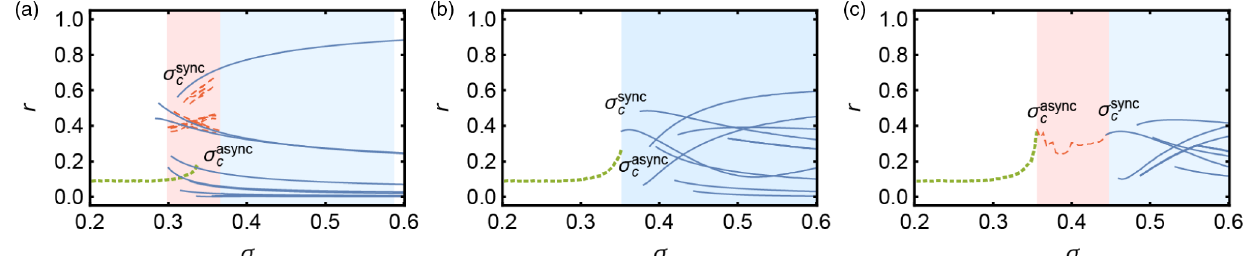
FIG. 9. Impact of oscillator heterogeneity for one profile. Order parameter r vs coupling strength σ for (a) small heterogeneity ( δ ¼ 0 . 005 ), (b) moderate heterogeneity ( δ ¼ 0 . 020 ), and (c) large heterogeneity ( δ ¼ 0 . 040 ). The lines indicate the asynchronous branch (green, dotted), fully phase-locked branches (blue, continuous), and partially phase-locked branches (red, dashed). As the heterogeneity increases, the phase-locked solutions move to the right, and the partially locked solutions disappear. The blue shade marks regions where only fully phase-locked solutions are present. The red shaded area in (a) marks the region where partially locked states exist and in (c) marks the region of stabilized chimera